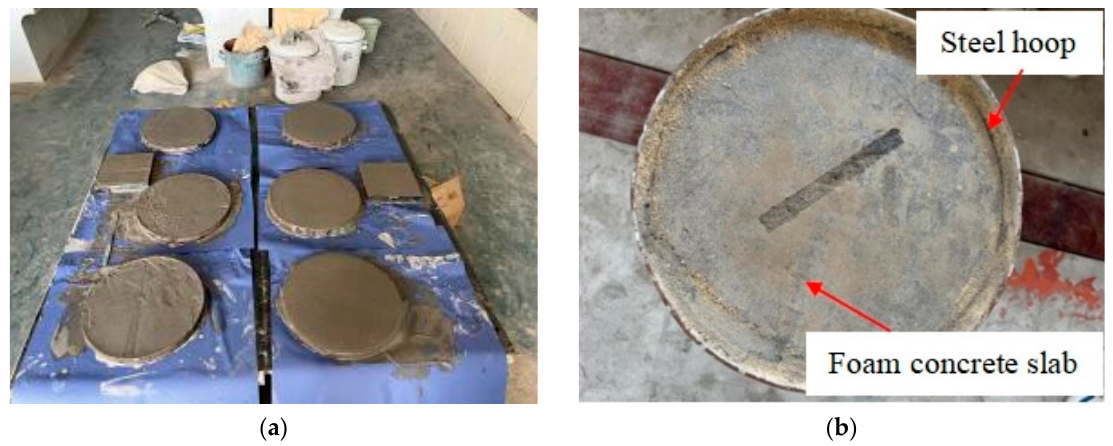
Figure 1. Test photos of foam concrete slabs restrained by steel hoops: ( a ) preparation; ( b ) photo of foam concrete slab after loading.